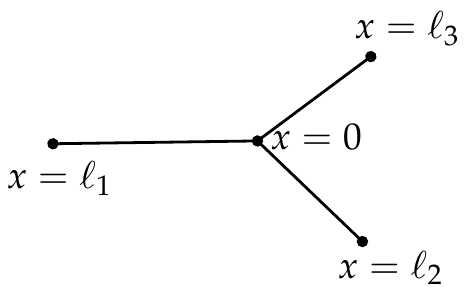
Figure 3. Star with coordinate system: e j identified with [ 0, (cid:96) j ]